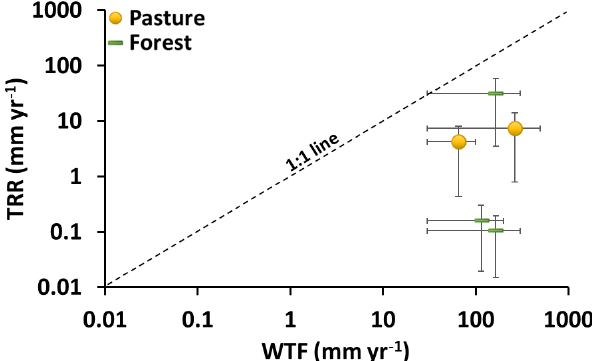
Figure 8. Comparison between recharge rates for the regional groundwater estimated from WTF and TRR. Bars represent the ranges of calculated recharge values from Table